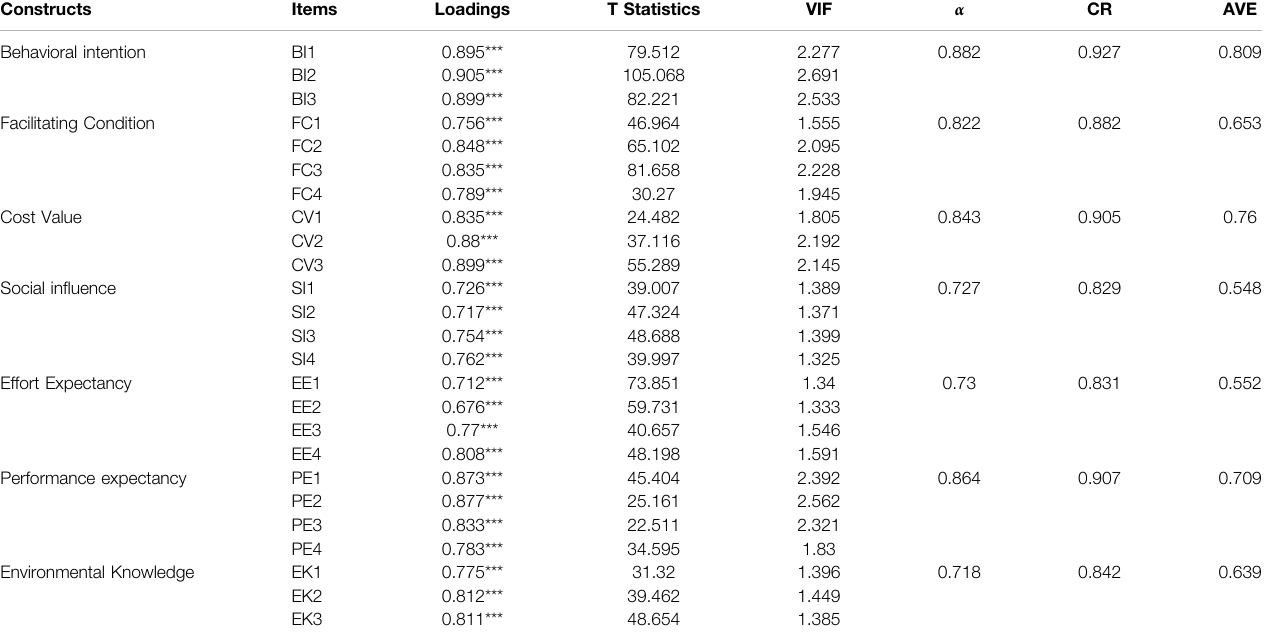
TABLE 2 | Reliability and validity analysis.